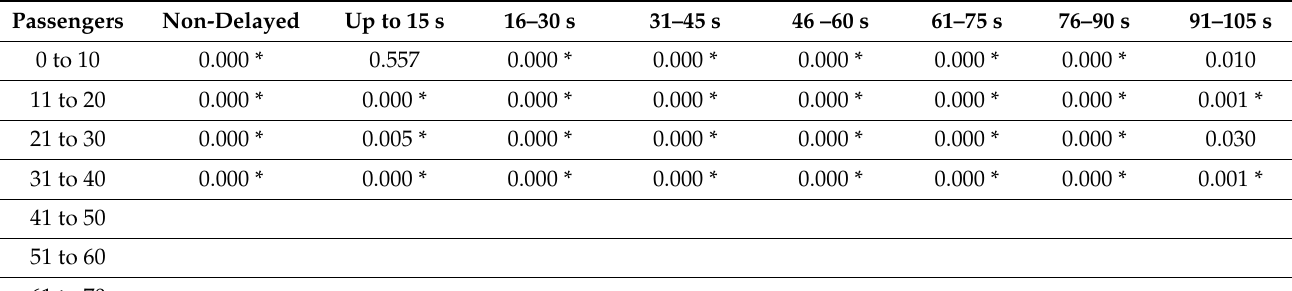
Table 3. Pairwise comparison for stations with a scheduled dwell time of 42 s. Significant results are